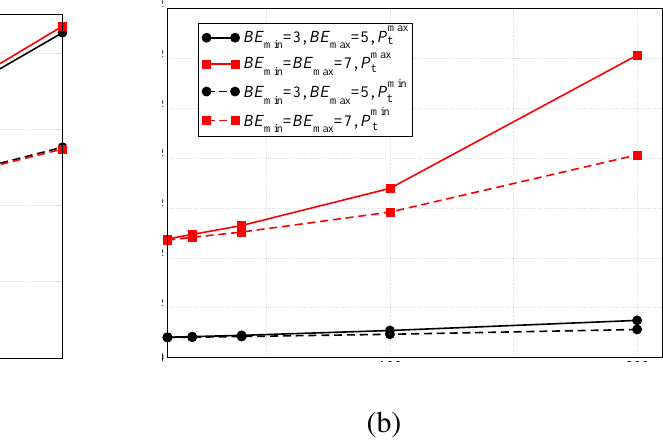
= 3 and BE = 5 , min max = BE = 7 . Different values of transmit min max